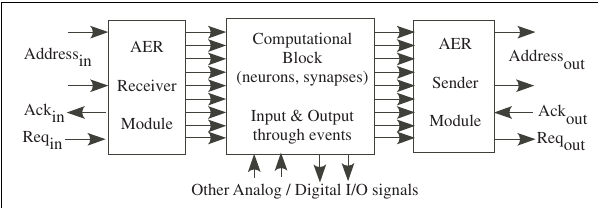
FIGURE 9 | Block diagram of our address event representation (AER) communication scheme. AER approach is used to interface the input and output events (action potentials) of a network of neurons to the outside world. We use an AER receiver to get input events, and an AER transmitter to send output